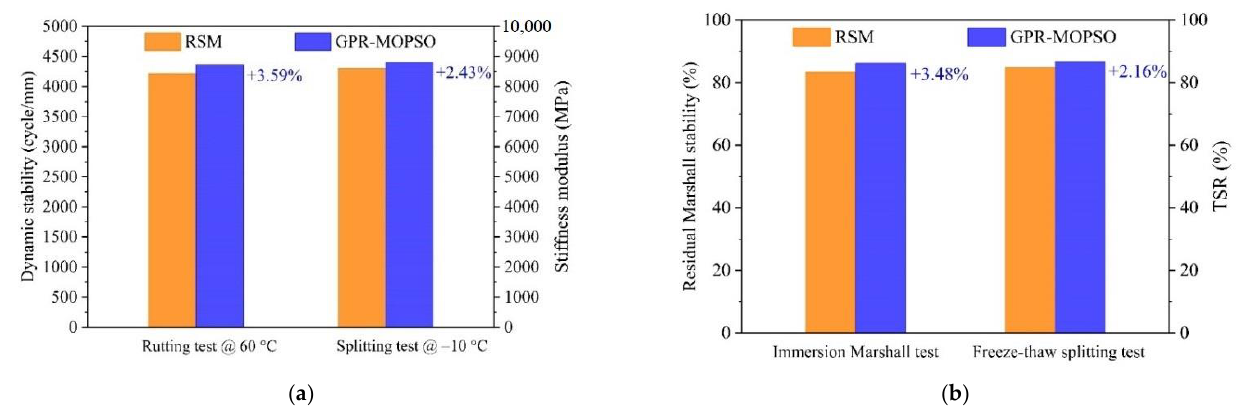
Figure 8. Performance verification between the RSM and GPR-AWMOPSO algorithm: ( a ) high- and low-temperature performances; and ( b ) moisture stability.